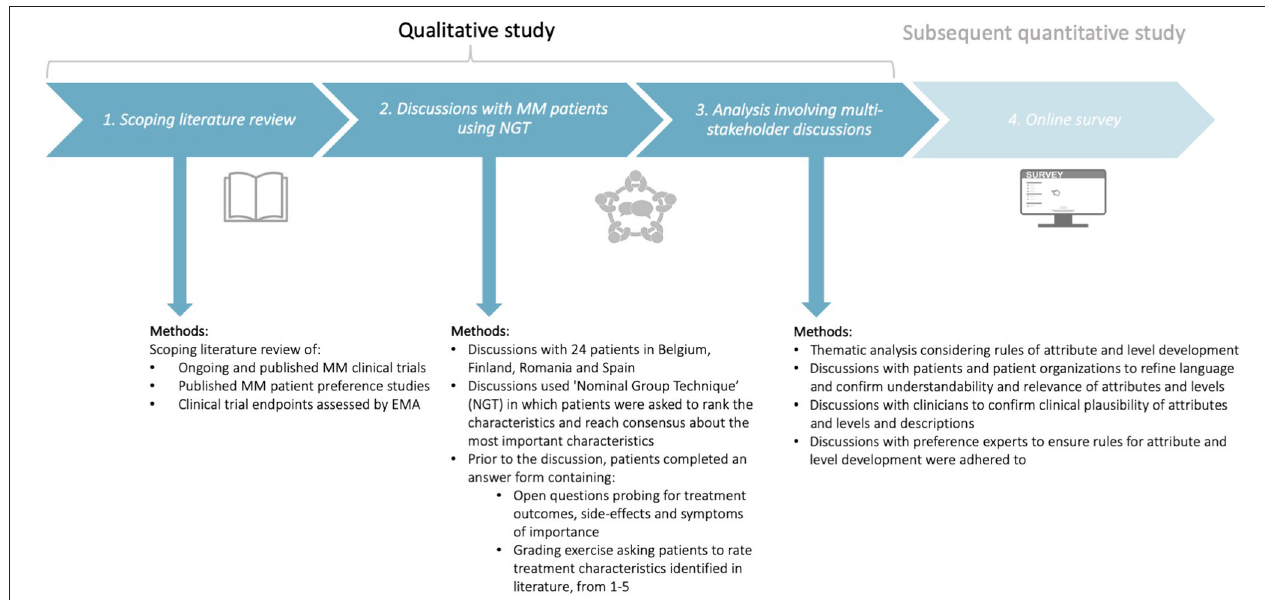
FIGURE 1 | Design of the qualitative study consisting of three phases: (i) a scoping literature review, (ii) discussions with MM patients using Nominal Group Technique (NGT), and (iii) analysis involving multi-stakeholder discussions with patients, patient organizations, clinicians, and preference experts. The subsequent quantitative study will be conducted using the attributes and levels identified in the present qualitative study. MM, Multiple Myeloma; NGT, Nominal Group Technique; EMA, European Medicines